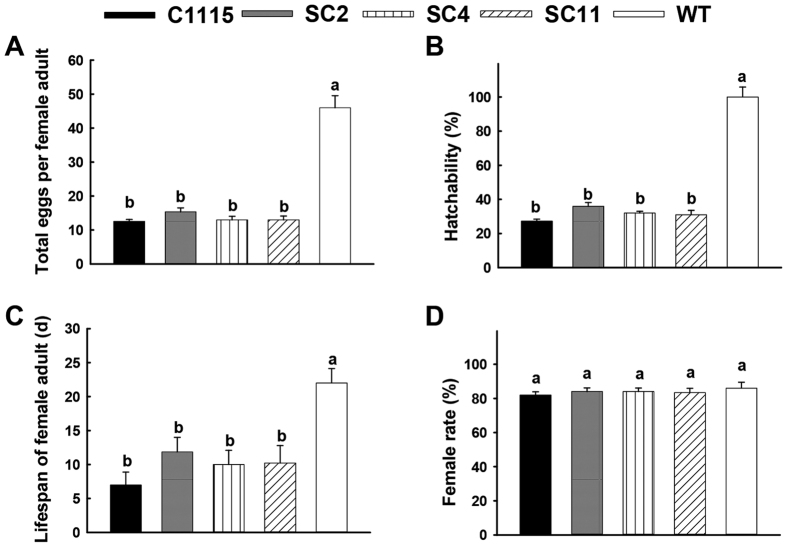
Influence of transgenic cassava lines on the development and reproduction of T. cinnabarinus.(A) Reproduction (total eggs per female adult). (B) Hatchability. (C) Lifespan of female adult. (D) Sex ratio (female rate). Different letters above the standard error bars indicate significant differences based on the one-way ANOVA followed by Tukey’s HSD multiple comparison test (P < 0.05).